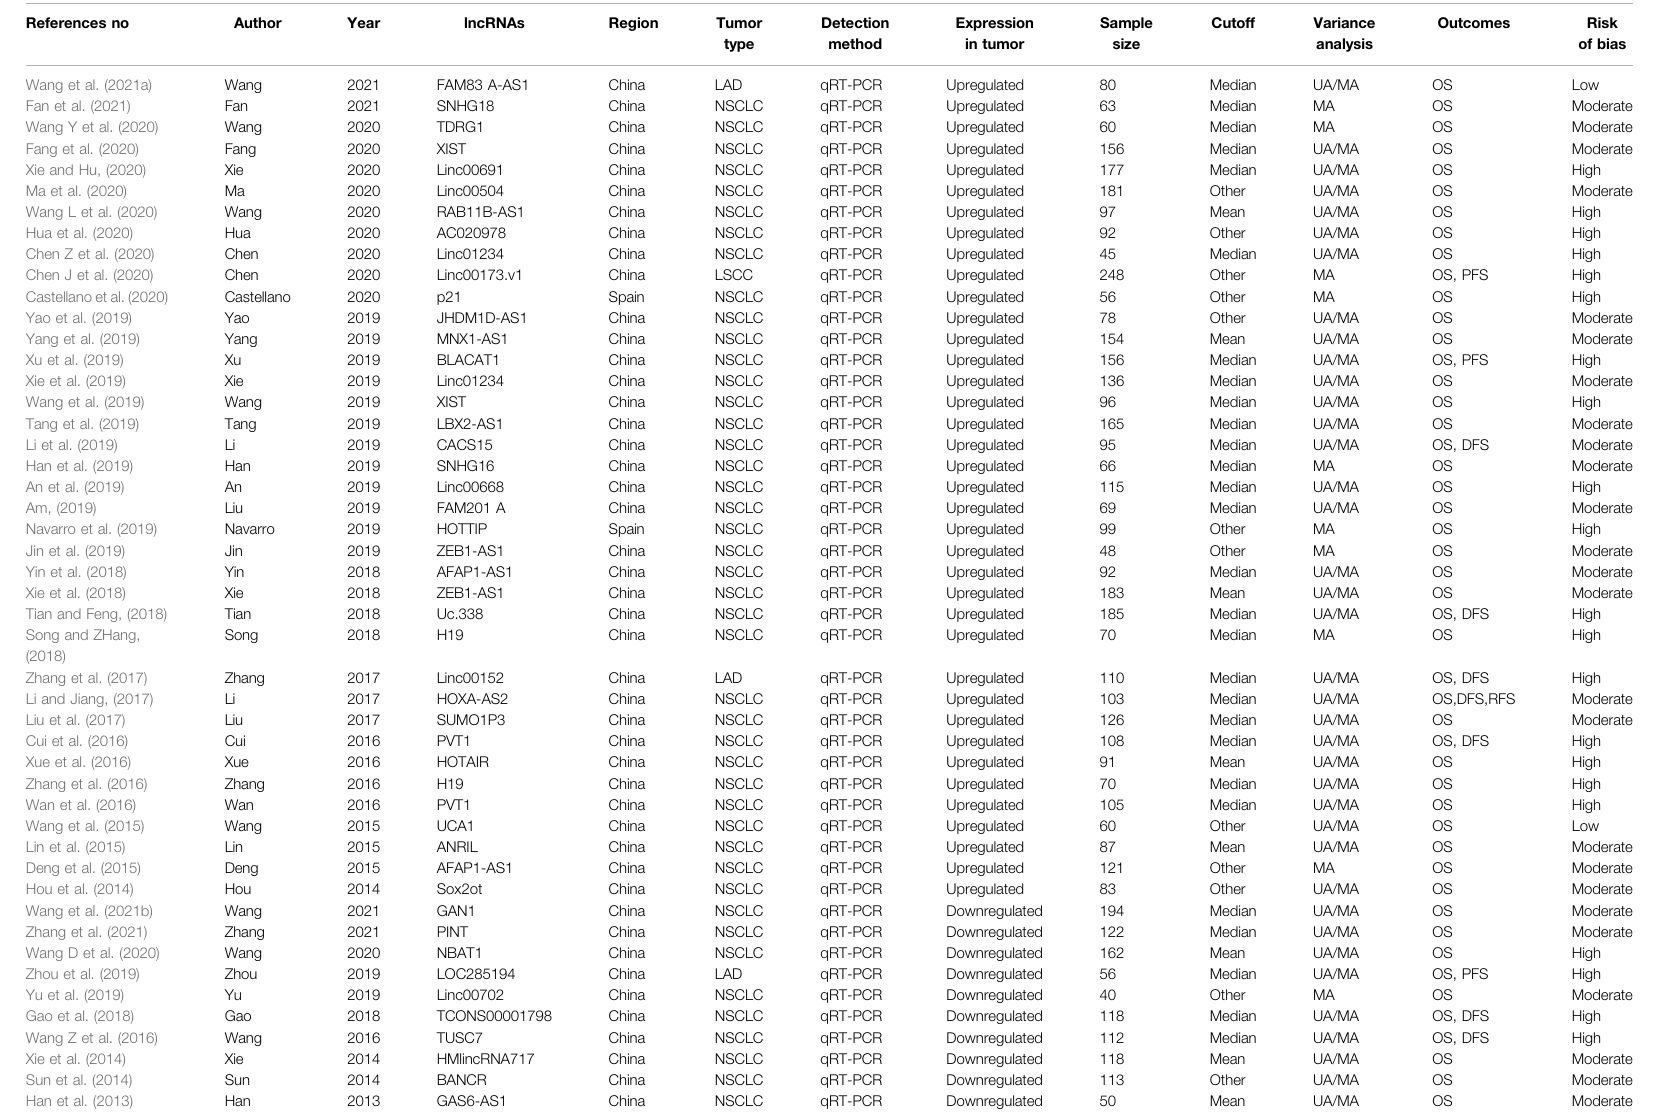
TABLE 1 | Characteristics of studies included in this meta-analysis.